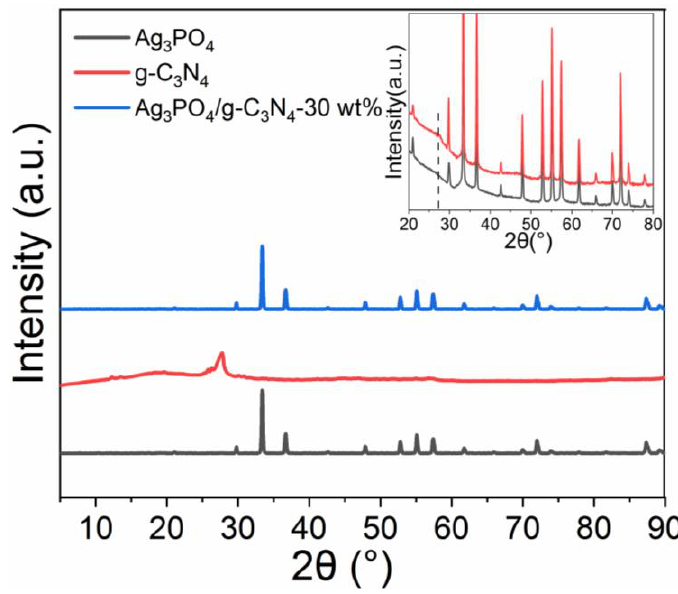
Figure 1. XRD patterns of as-prepared Ag 3 PO 4 , g-C 3 N 4 , and Ag 3 PO 4 /g-C 3 N 4.